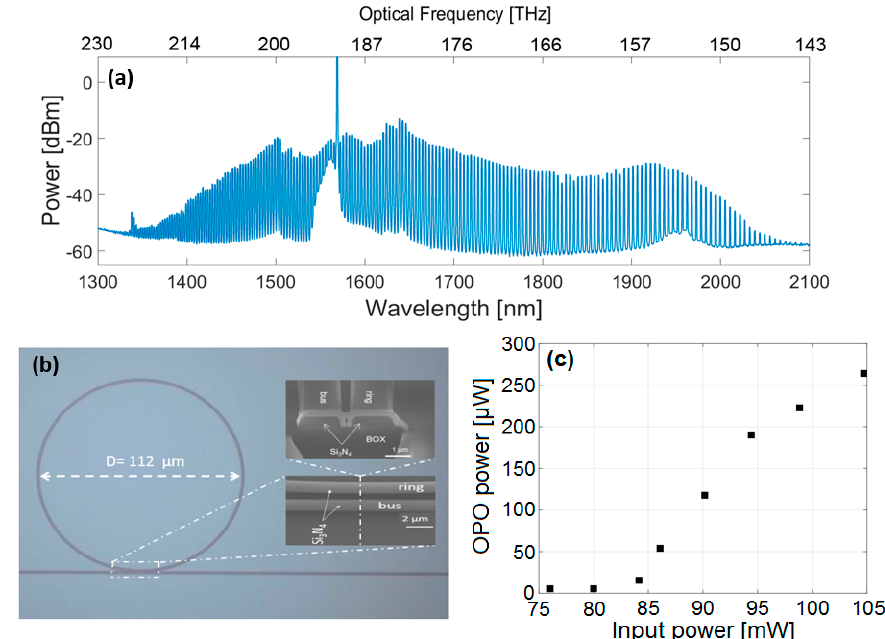
Figure 5. Comb generation using annealing-free silicon nitride on insulator. ( a ) An 800-nm-spanning comb generation using a 56- µ m-radius Si 3 N 4 microresonator for P in ~ 1 W. ( b ) Optical microscope and (insets) scanning electron microscope images of the ring and coupling region. ( c ) Plot of short-wavelength OPO power with input power in the bus waveguide.